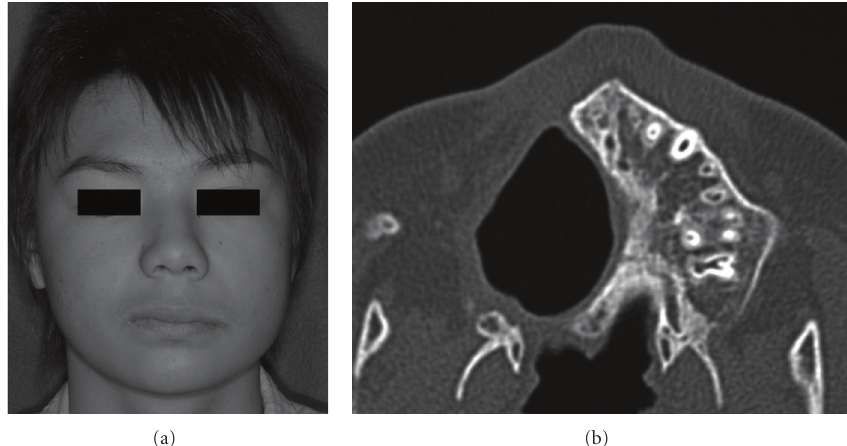
Figure 3: (a) Nine years after surgery, the patient has a normal appearance although the right corner of the mouth is slightly higher than the left. (b) CT taken at 9-year followup, showing the defect in the maxilla and no recurrence of